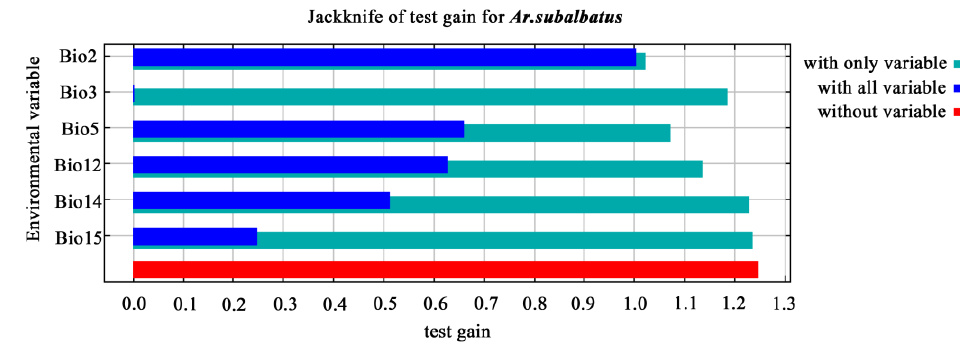
Figure 5. The key bioclimatic variables affecting the distribution of Ar. subalbatus . Bio 2: Mean diurnal temperature range (°C); maximum temperature of warmest month (°C) (Bio5, 9.7%); Bio15: precipitation seasonality; isothermality (°C) (Bio3, 1.2%), annual precipitation (mm) (Bio12, 3.5%), and precipitation of driest month (mm) (Bio14, 0.2%).